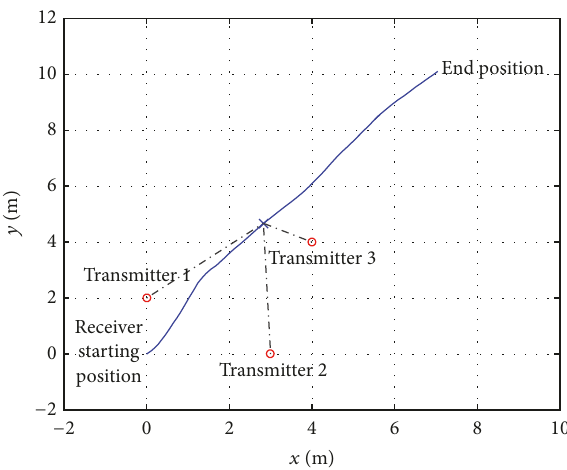
Figure 6: Simulated scenario with three transmitters indicated by the red circles and a receiver moving on the blue track. The figure indicates the propagation paths from the transmitters to the receiver for 𝑘 = 30